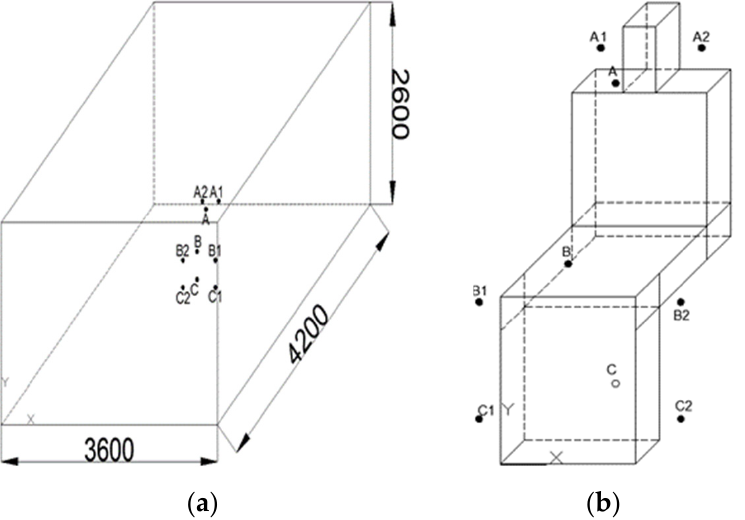
Figure 3. ( a ) The distribution of the measurement points in the experimental cabin. ( b ) The measurement points around the human body.